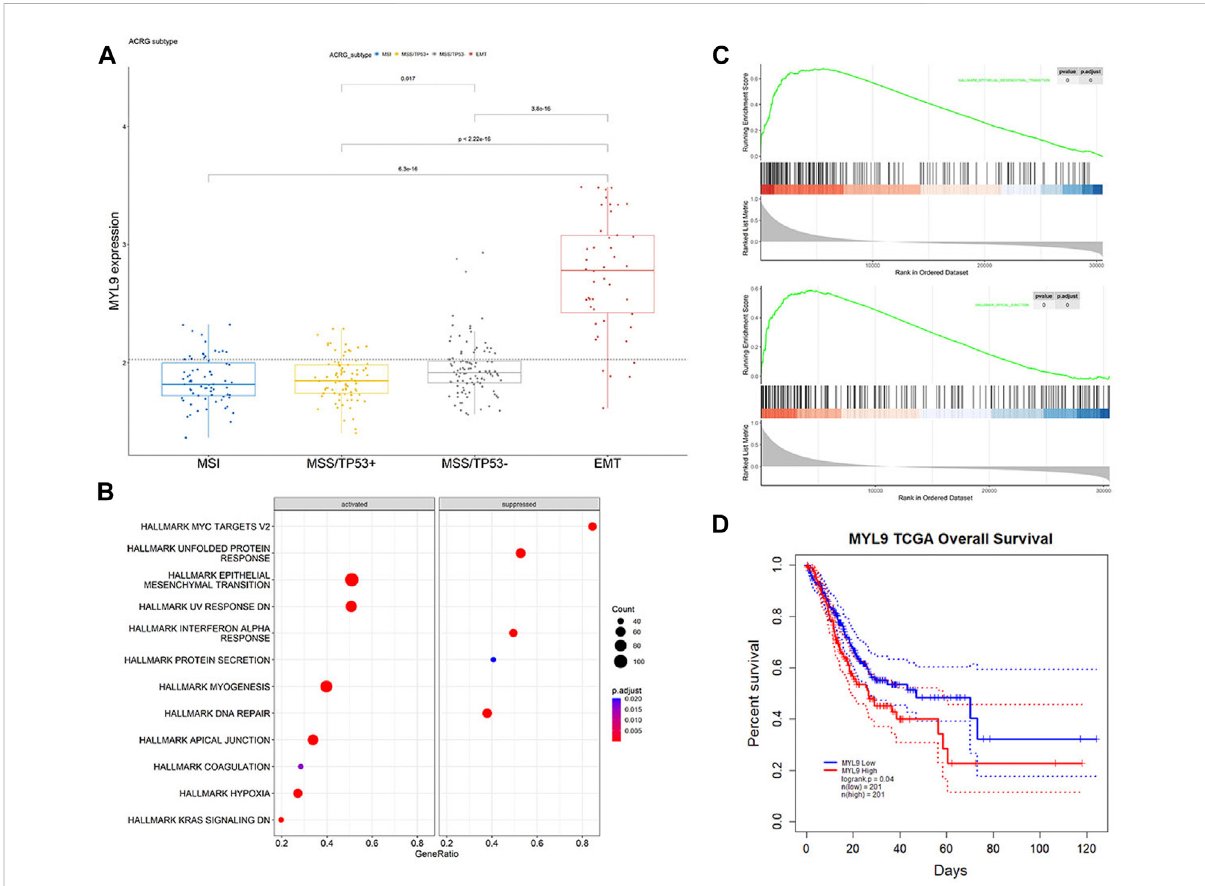
FIGURE 6 MYL9 is positively correlated with EMT. (A) The expression of MYL9 in four different stages (MSI, MSS/TP53 + , MSS/TP53 - , EMT) of ACRG data cohort. The thick line represents the median value. The bottom and top of the boxes are the 25th and 75th percentiles (interquartile range), respectively. (B) Gene set enrichment analysis (GSEA) of MYL9; (C) GSEA revealed signi fi cantly activated signaling pathways of MYL9 (D) Survival impact of the MYL9 expression, Kaplan-Meier curves for overall survival (OS) in TCGA-STAD